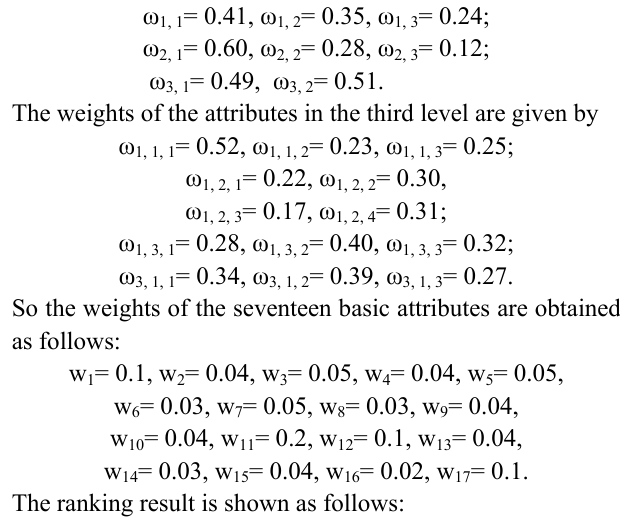
Table 6. Ranking result of strategic R&D projects using the weights calculated for manufacturing department Ranking